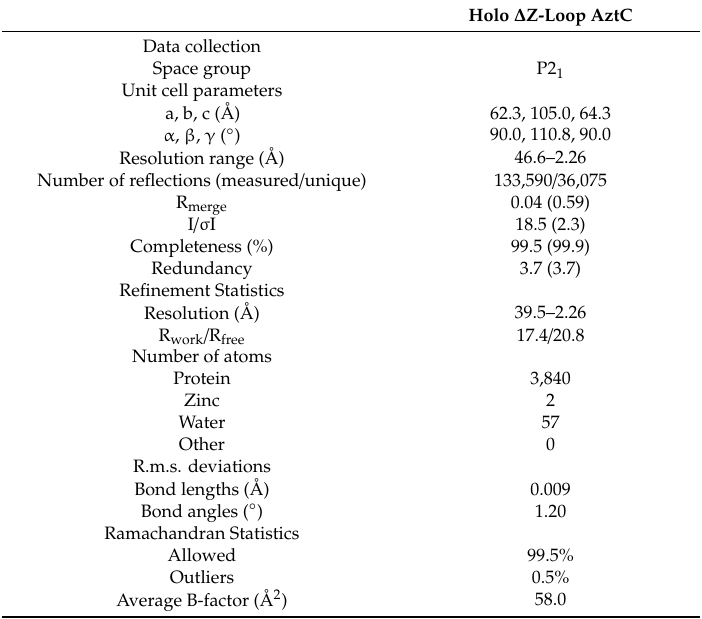
Table 2. X-ray di ff raction data collection, processing and refinement